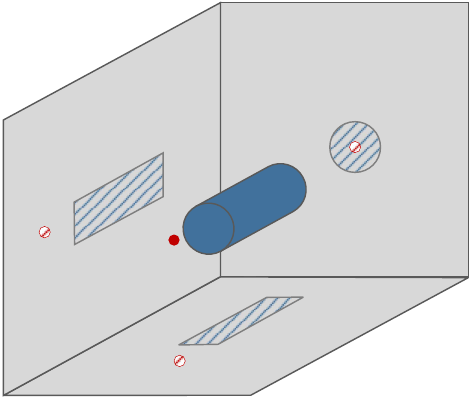
Figure 4. Representative example of Convex Hull